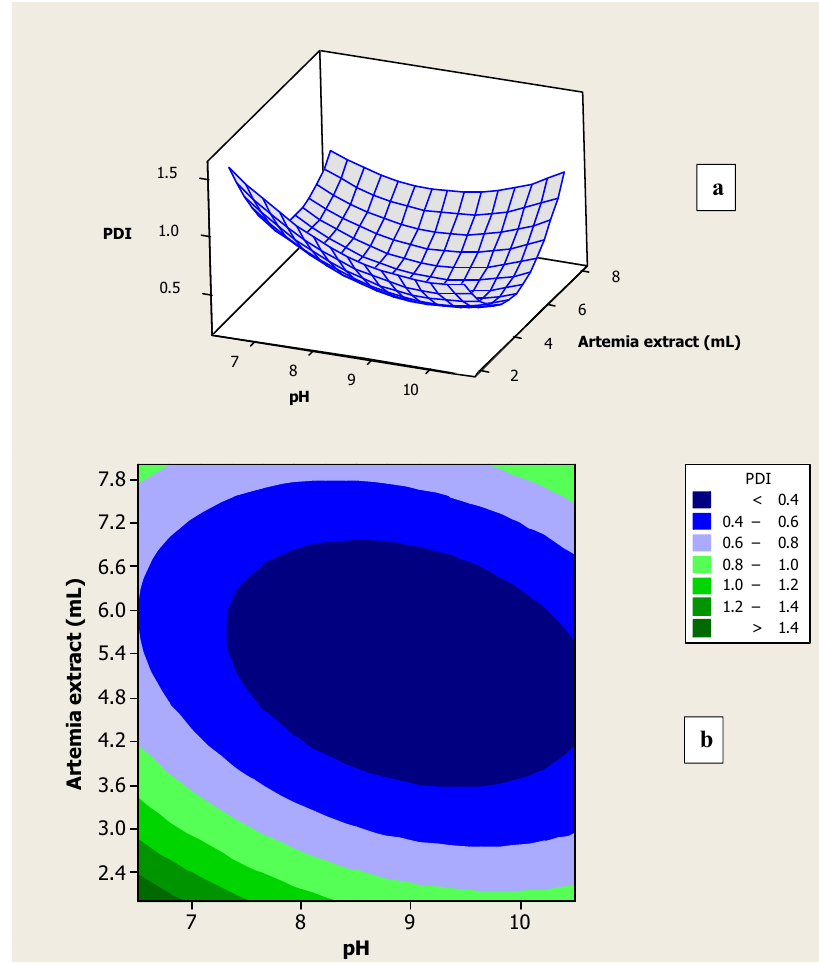
Figure 3: Surface plot ( a ) and contour plot ( b ) for PDI of the fabricated Au NPs as a function of amount and pH of the prepared A. urumiana